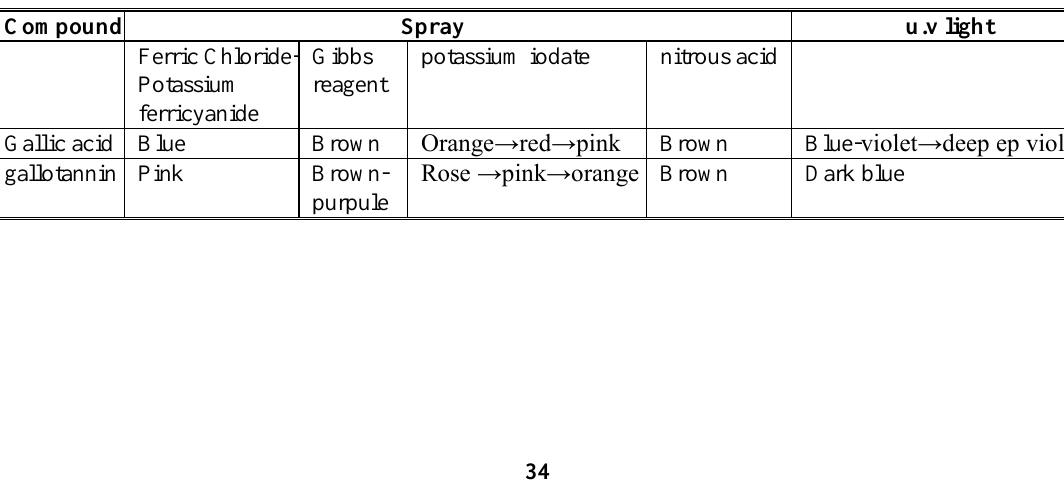
Table(1) : Detection of gallic acid and gallotannin by various sprays